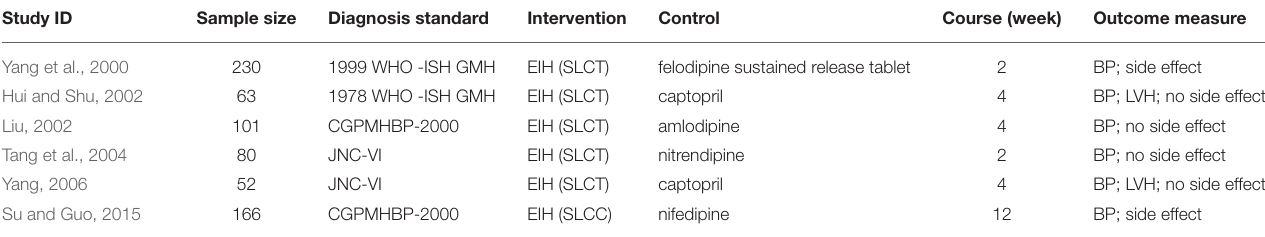
TABLE 1 | Characteristics of included